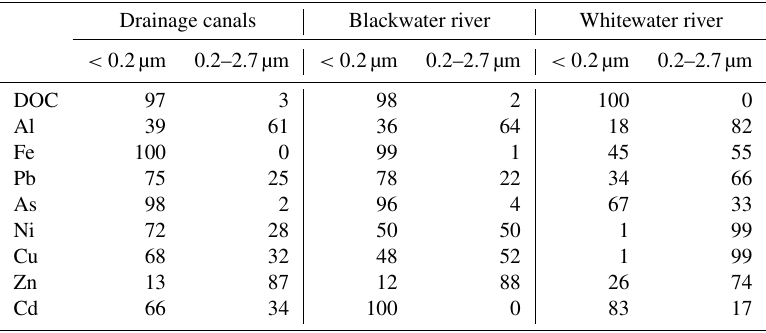
Table 3. Proportion of DOC and selected trace metals in the form of dissolved and fine colloids ( < 0 . 22µm) and coarse colloids (0.2–2.7µm). Drainage